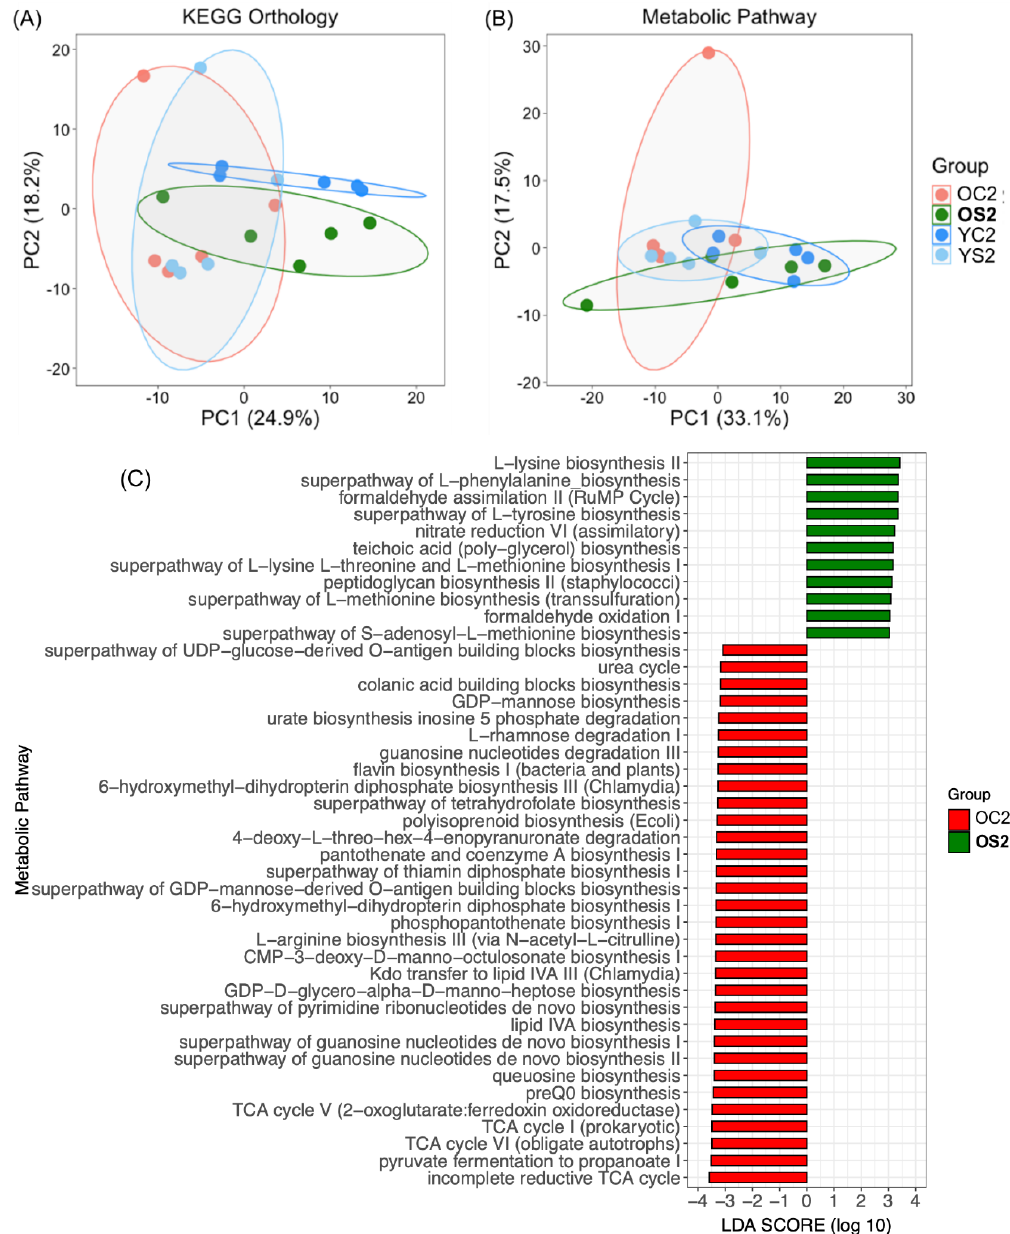
Figure 5. Comparative analyses of the inferred functional profiles of the gut microbiome. ( A ) Principal coordinate analysis (PCoA) of inferred functional profiles by KEGG Orthology in different experimental groups, ( B ) PCoA of inferred metabolic pathway profiles based on the MetaCyc database. The colored ellipses indicate 70% confidence intervals for each group. ( C ) Metabolic pathways with a significant difference between old control mice (OC2) and old mice treated with SFN ( OS2 ) ( p < 0.05 by the Wilcoxon test) using linear discriminant effect size analysis. LDA scores < 0 indicates that corresponding features are enriched in OC2.